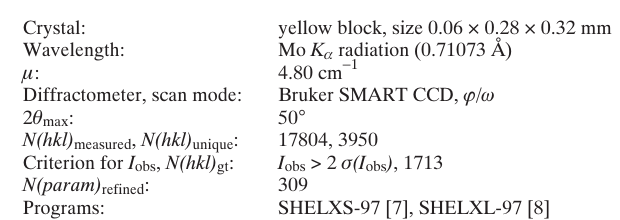
Table 1. Datacollection and